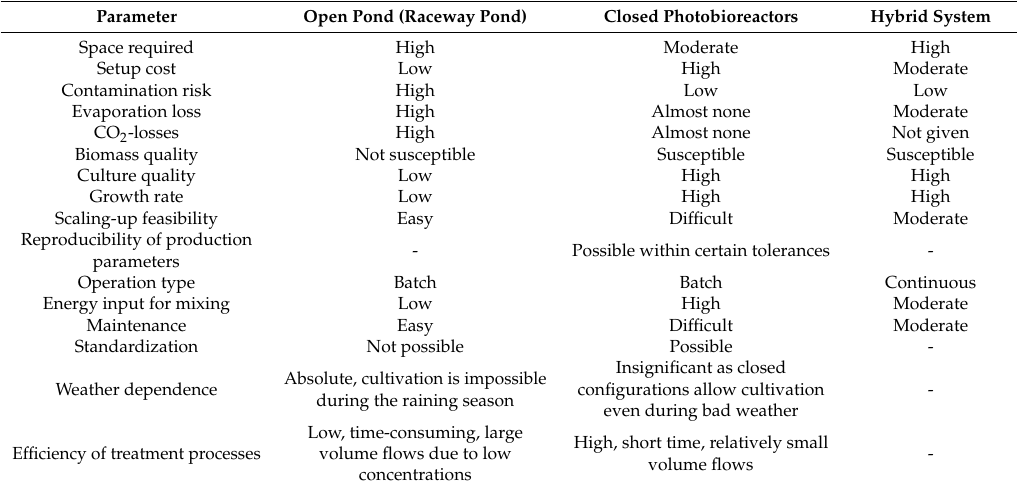
Table 3. Comparison of open, closed, and hybrid microalgae photobioreactor facilitated cultivation systems [29,39].